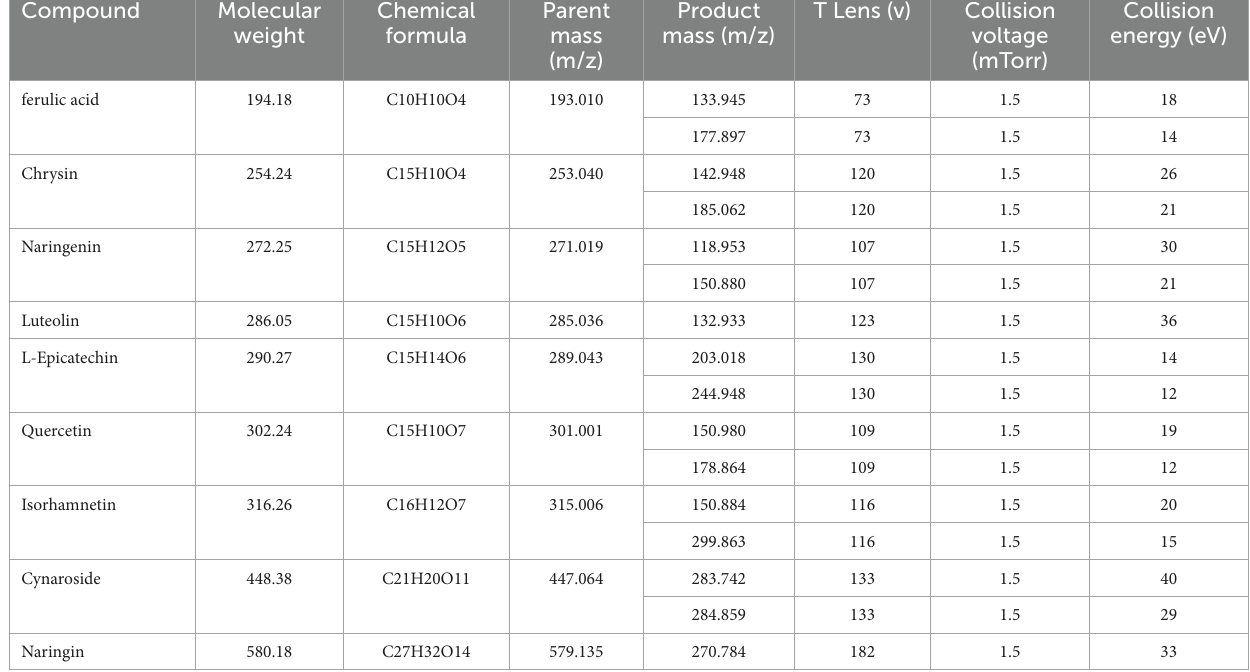
TABLE 1 Mass spectral parameters of the nine components.